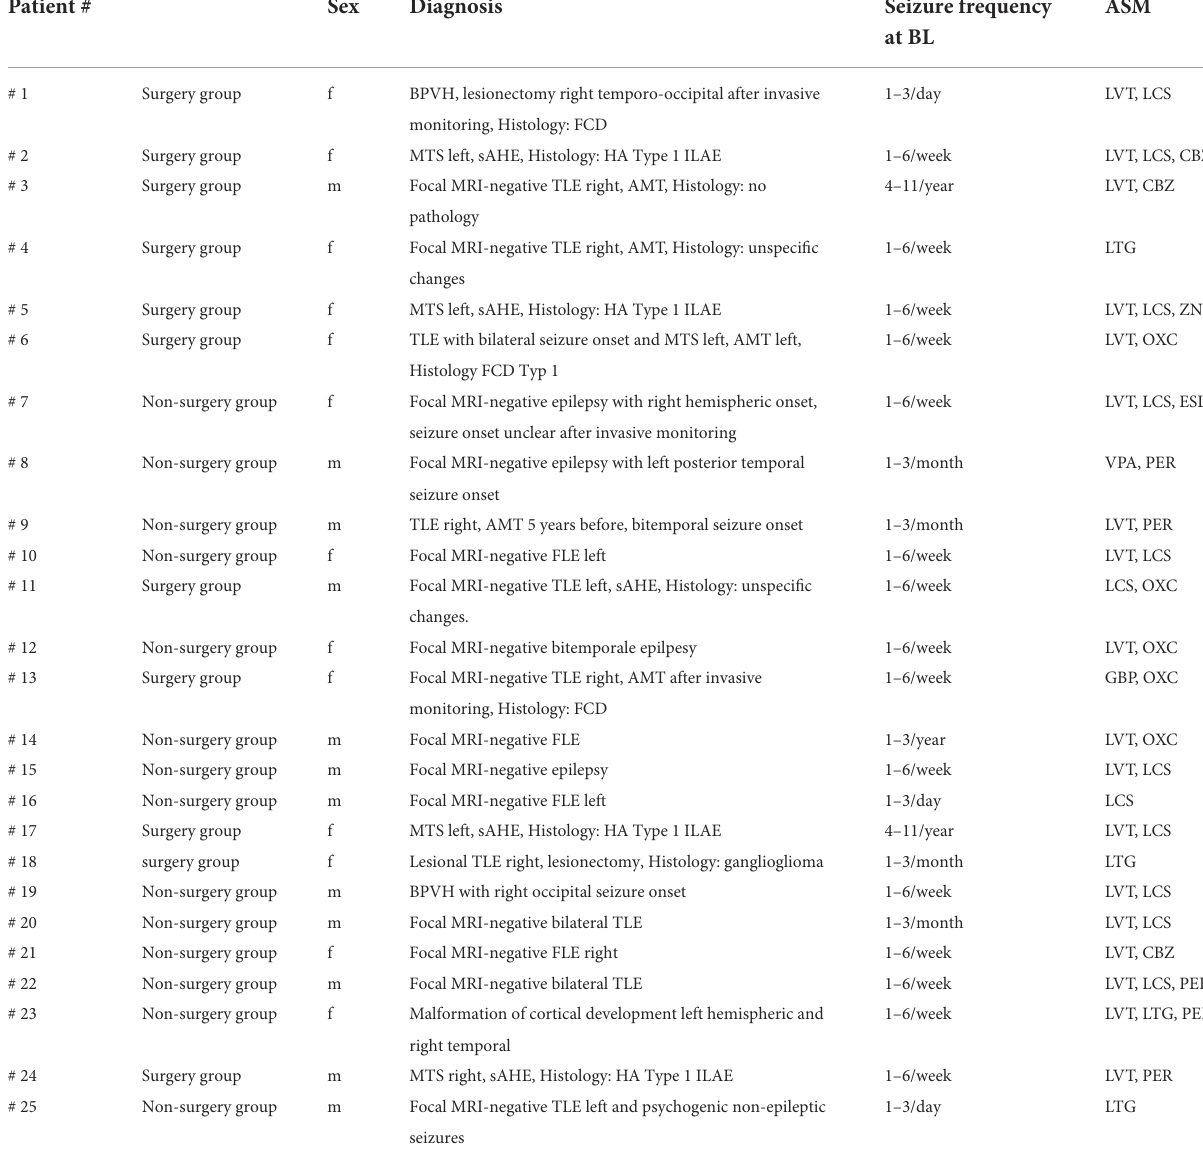
TABLE 1B Clinical data at